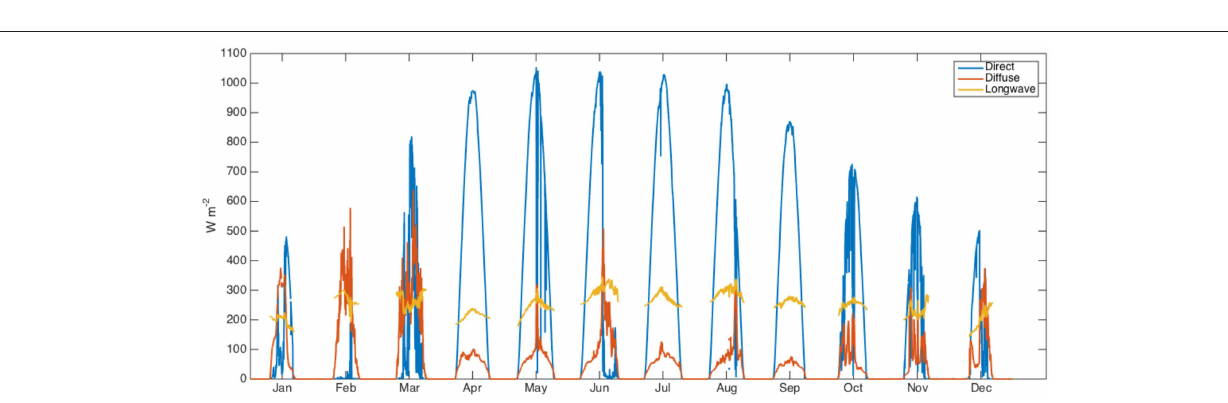
FIGURE 8 | Solar radiation at CUES. Mid month incoming solar radiation for calendar year 2012. The curves show the measured incoming radiation on the 15th day of each month. The horizontal axis is truncated between each day. Direct and diffuse are measured over the solar spectrum. Longwave is measured over the thermal infrared